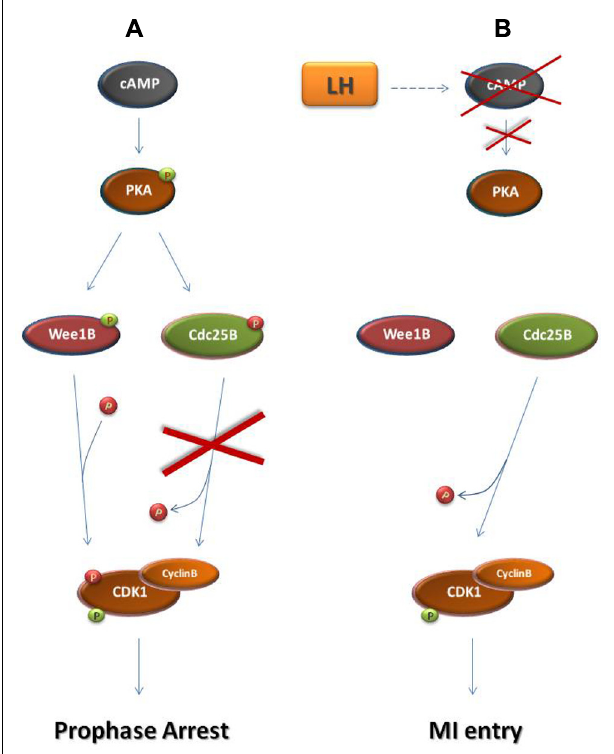
FIGURE 3 | Regulation of prophase arrest and resumption of meiosis. (A) Regulation of prophase arrest. During the arrested state, a signaling pathway that is established in response to the interactions of the oocyte with its neighboring granulosa cells leads to the accumulation of cAMP in the oocyte. cAMP causes the phosphorylation of protein kinase A (PKA). Similarly to Chk1 and Chk2 during the G2 DNA damage checkpoint, PKA in prophase-arrested oocytes phosphorylates and activatesWee1 kinase and specifically theWee1 isoformWee1B. Furthermore, PKA phosphorylates and inhibits Cdc25B phosphatase. As a result, Cyclin B-CDK1 remains inactive and the oocyte arrested in meiotic prophase. (B) Resumption of meiosis. During the estrus cycle, the surge of the luteinizing hormone (LH) drives a signaling cascade that results in the decline of cAMP levels in the oocyte.This leads to PKA inactivation, ending the PKA-dependent phosphorylation ofWee1B and Cdc25B. Just as in M-phase entry in somatic cells,Wee1B becomes inactive and Cdc25B is activated in order to remove the inhibitory phosphates from CDK1. In response to Cyclin B-CDK1 activation, the oocyte enters the first meiotic M-phase. : activating phosphate. : inhibiting phosphate.